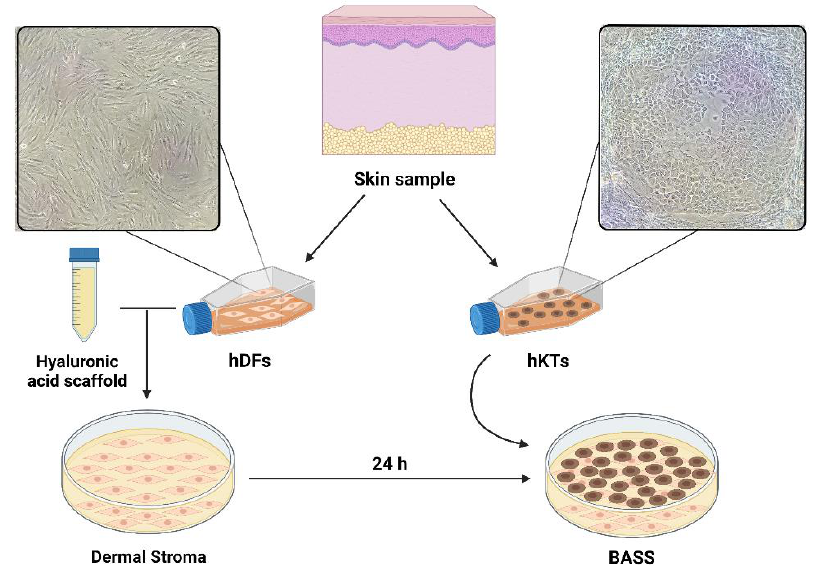
Figure 1. Schematic representation of cell culture and BASS manufacturing process. Created with BioRender.com. Human dermal fibroblasts (hDFs), human keratinocytes (hKTs), bioengineered autologous skin substitute (BASS).